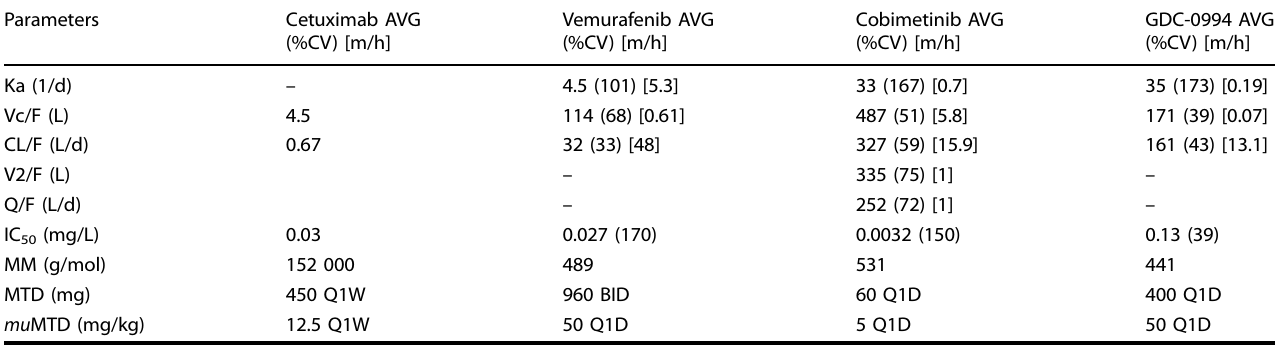
Table 1. Pharmacological properties of drugs included in the model